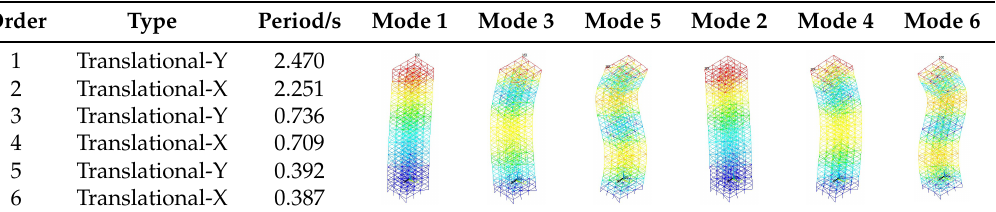
Figure 5. Basic information of the 30-story building model. Table 2. Dynamic property of the building.